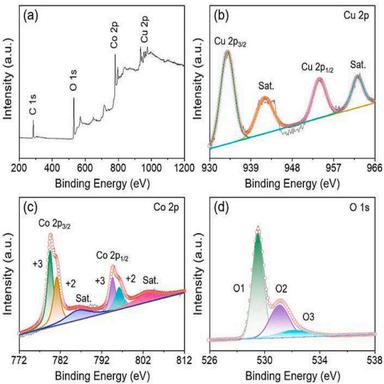
The XPS spectra of CuCo2O4/CuO microspheres: (a) the survey XPS spectrum, and the core-level XPS spectra of (b) Cu 2p, (c) Co 2p, and (d) O 1s, respectively.